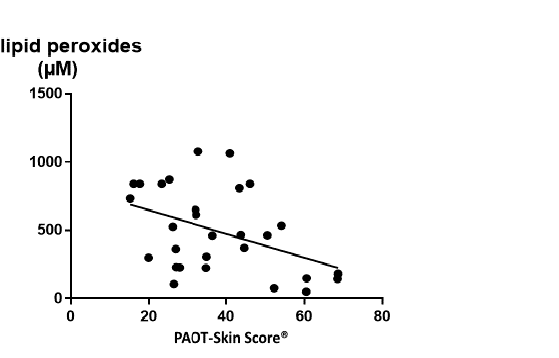
Figure 8. Negative correlation between the PAOT-Skin Score ® and blood lipid peroxides (r = − 0.43, p = 0.020). Table 6. Significant correlations found between PAOT-Skin Score ® and blood OS biomarkers (Group III).